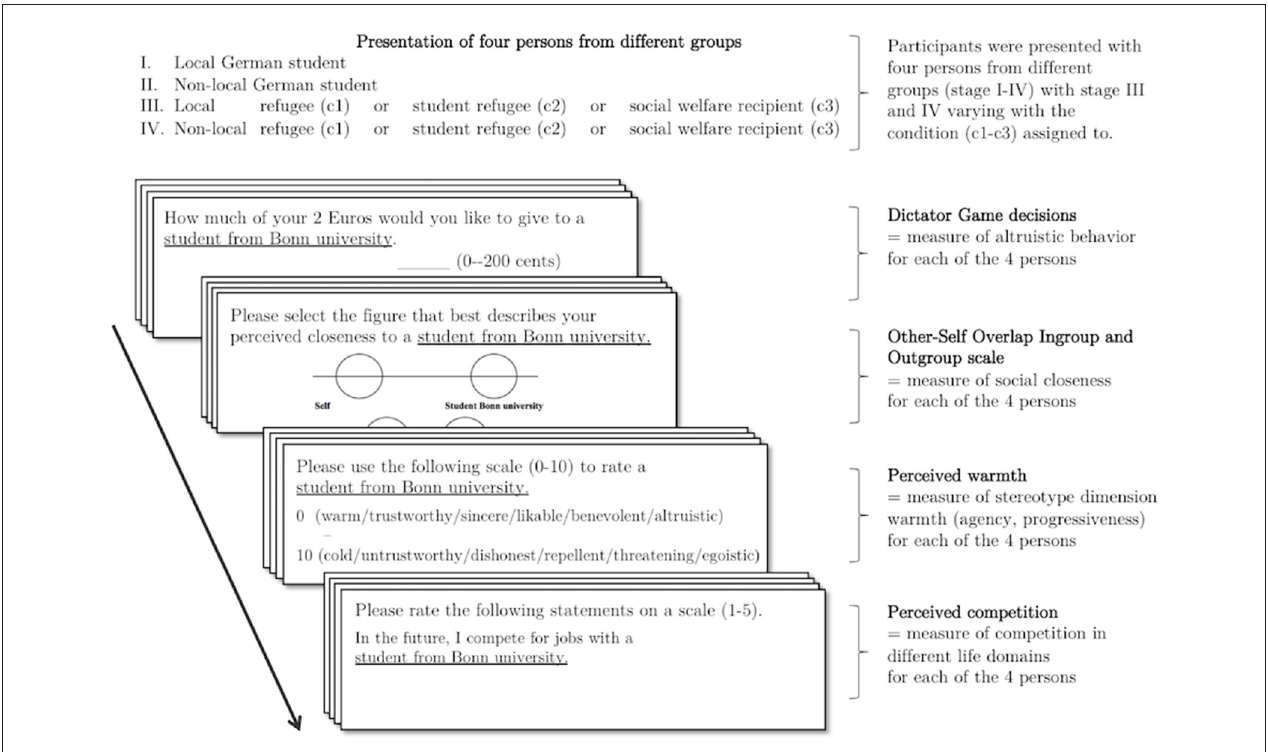
FIGURE 1 | Experimental procedure.